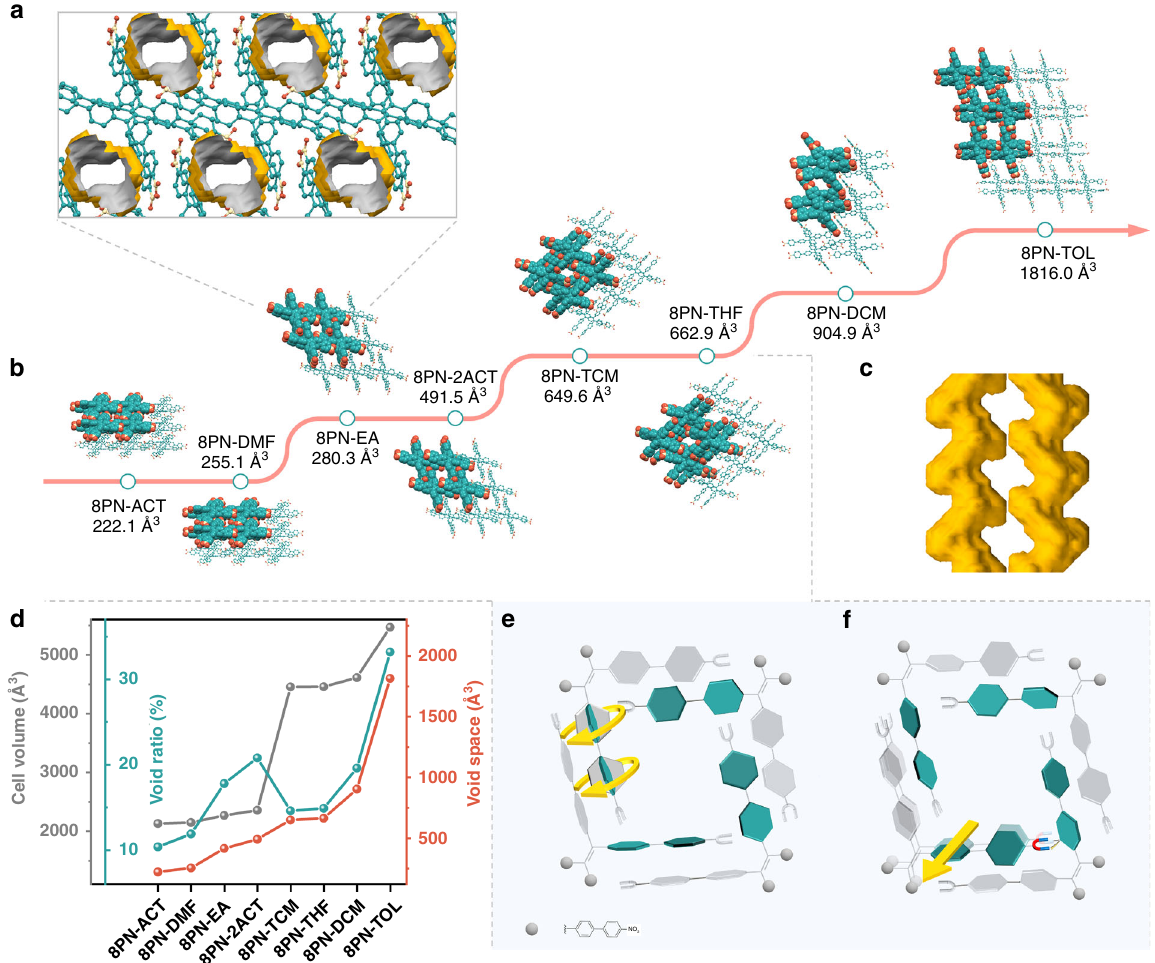
Fig. 2 Investigation of single-crystal structures of 8PN. a Packing diagram of 8PN-EA along the [010] direction, with the solvent-accessible void space visualized by gray/yellow (inner/outer) curved planes generated with a probe of 1.2 Å. Color code: green, C; yellow, N; Orange, O. H atoms are omitted